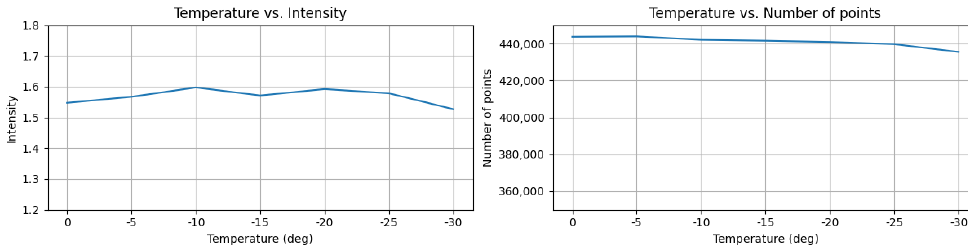
Figure 9. Example of high temperature test results. ( Left ) mean intensity versus ambient temperature ( Right ) number of points versus ambient temperature.